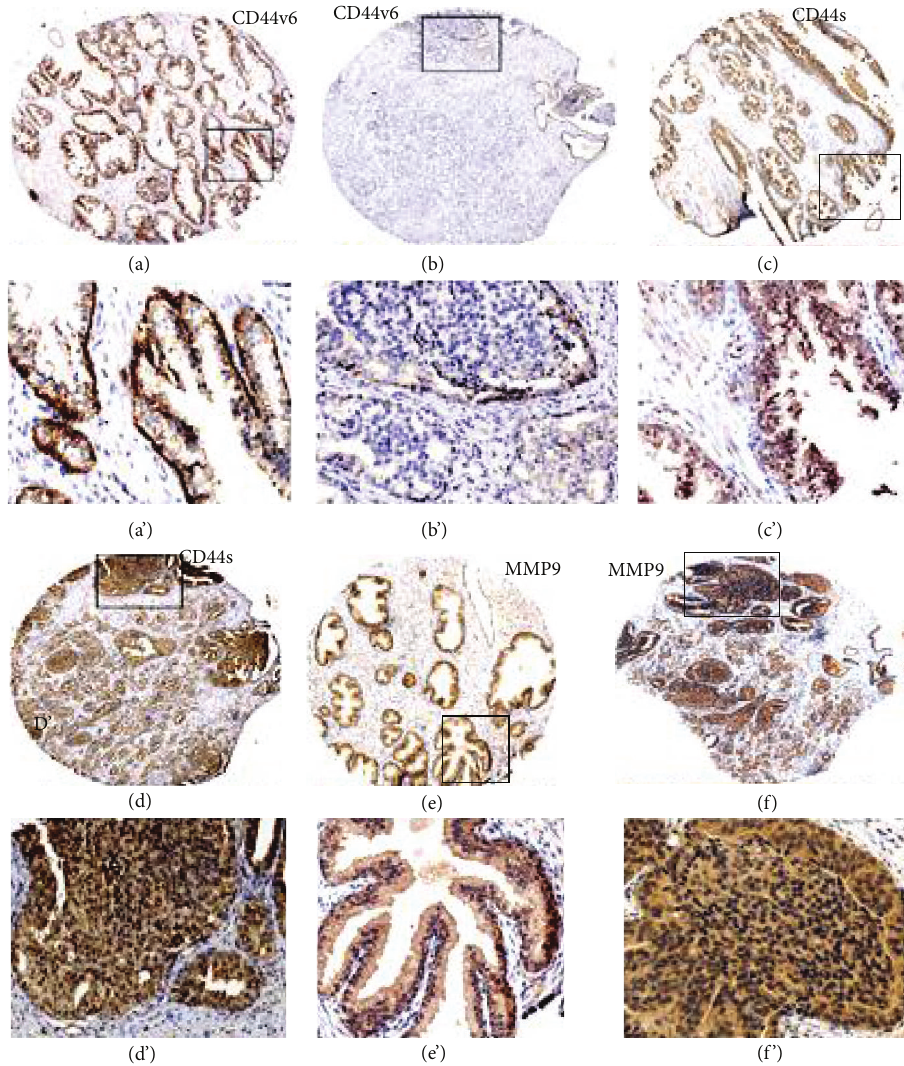
Figure 7: Immunohistochemical detection of CD44v6 (a) and (b), CD44s (c) and (d), and MMP9 (e) and (f) in normal (a), (c), and (e) and adenocarcinoma (grade 2-3; (b), (d), and (f)) sections of representative prostate tissues from a tissue microarray: immunostained sections (brown) with indicated antibody above were counterstained with hematoxylin stain (blue). Note the intense immunopositivity of basal epithelial membrane of epithelial cells in normal gland (indicated by arrows in (a’)). Magnification is 50 × in (a)–(f). Location of the high magnification (200 × ) regions shown in (a’)–(f’) is indicated by a rectangle field in (a)–(f). The staining was repeated thrice with similar